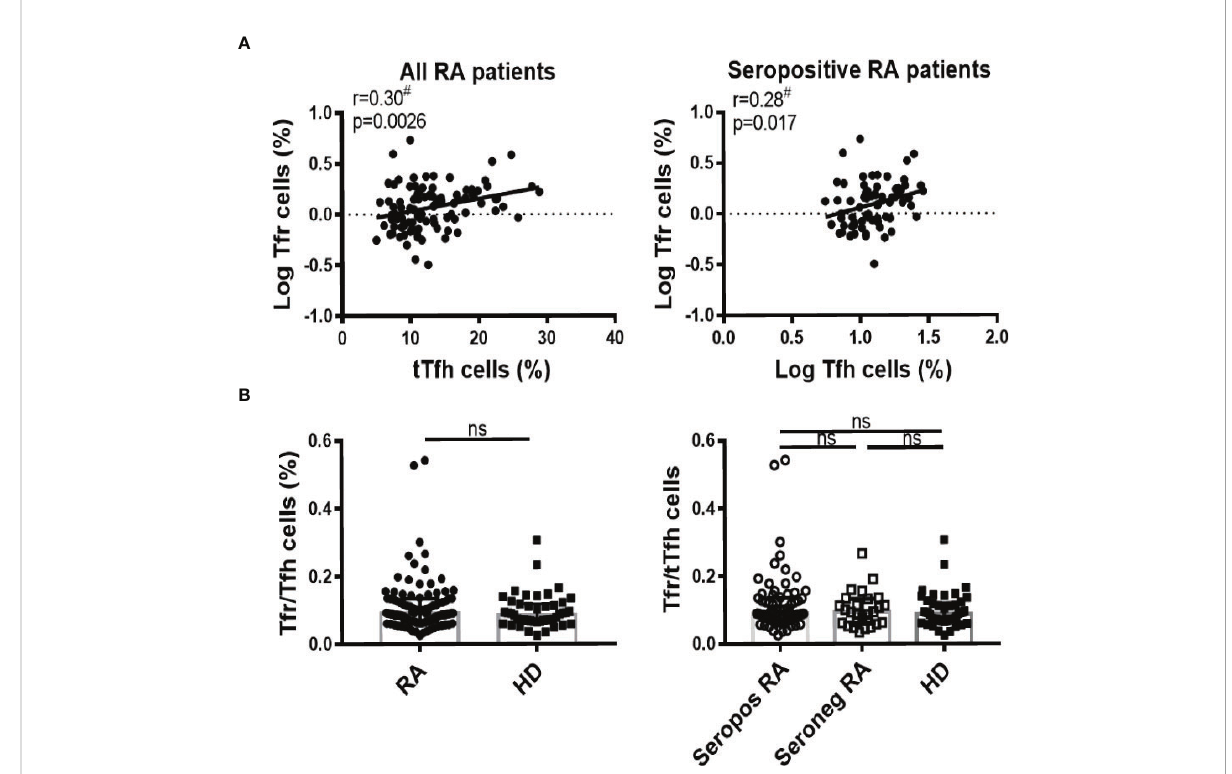
FIGURE 3 Correlation between Tfh and Tfr cells in RA patients. (A) Correlation between tTfh and Tfr cells frequency in all RA patients (n=99, left) or in seropositive RA patients (n=72, right). (B) Tfr/Tfh ratio in RA patients (n=99) vs HD (n=46) (left) or in seropositive (Seropos, n=72) and seronegative (Seroneg, n=27) RA patients and HD (right). Symbols represent individual subjects. # Pearson ’ s correlation coef fi cient r and P values are shown in (A) ; lines of best fi t were drawn. Median ± interquartile range is shown in (B) ; T-Test (left) and Kruskal-Wallis Test followed by Dunn ’ s Multiple Comparisons Test (right) were determined in (B) . ns, not signi fi